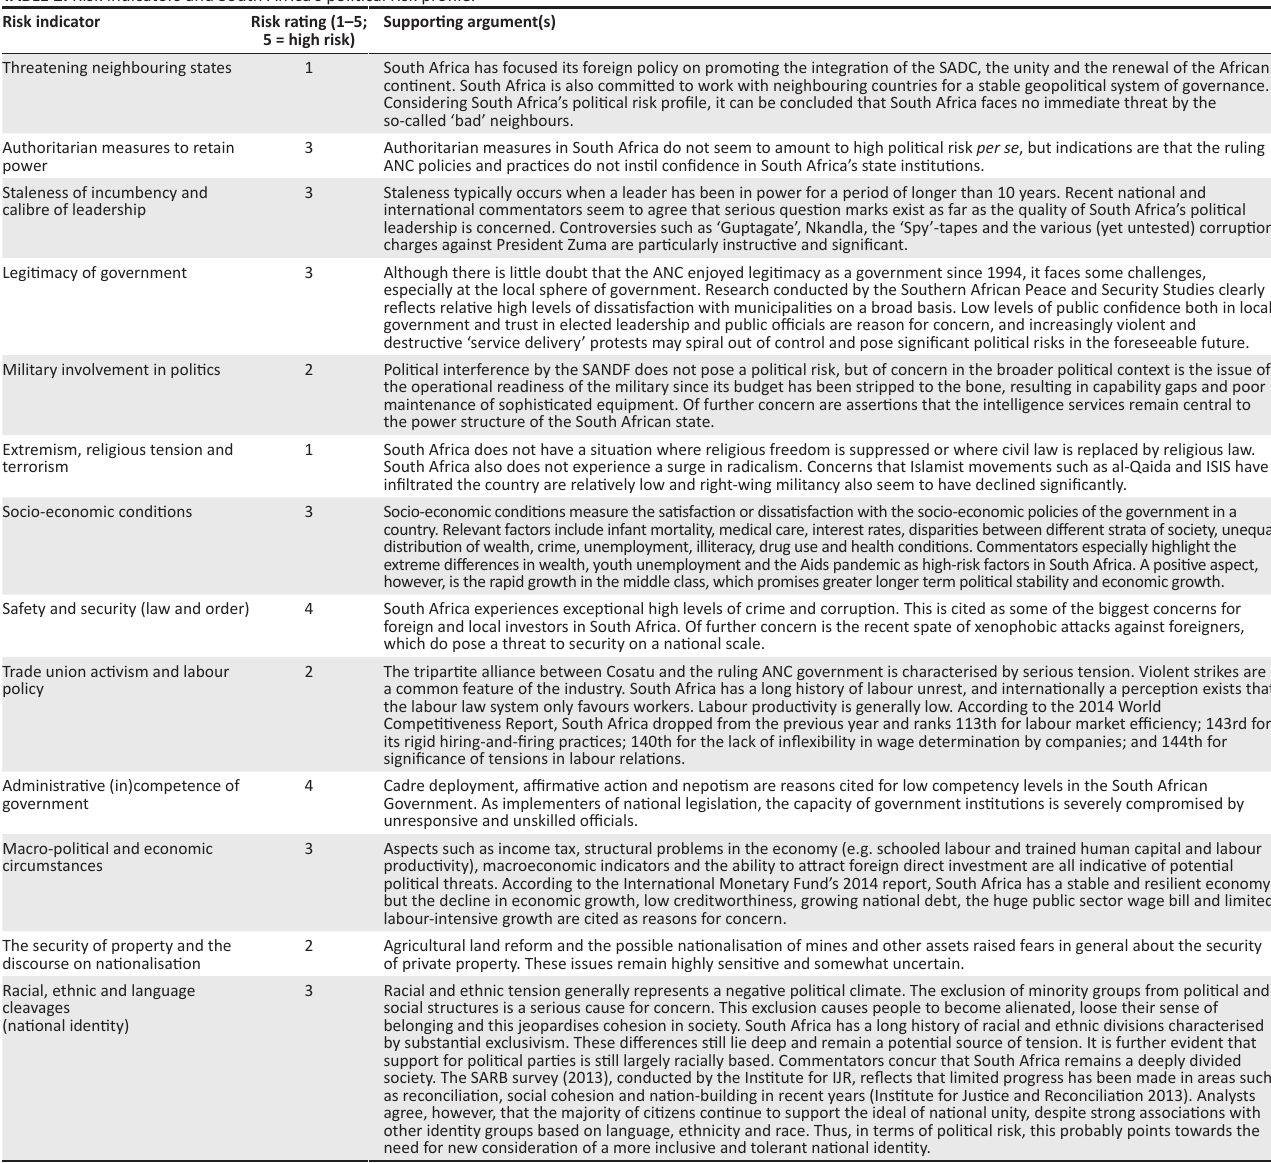
TABLE 2: Risk indicators and South Africa’s political risk profile. Risk indicator Risk rating (1–5; 5 = high